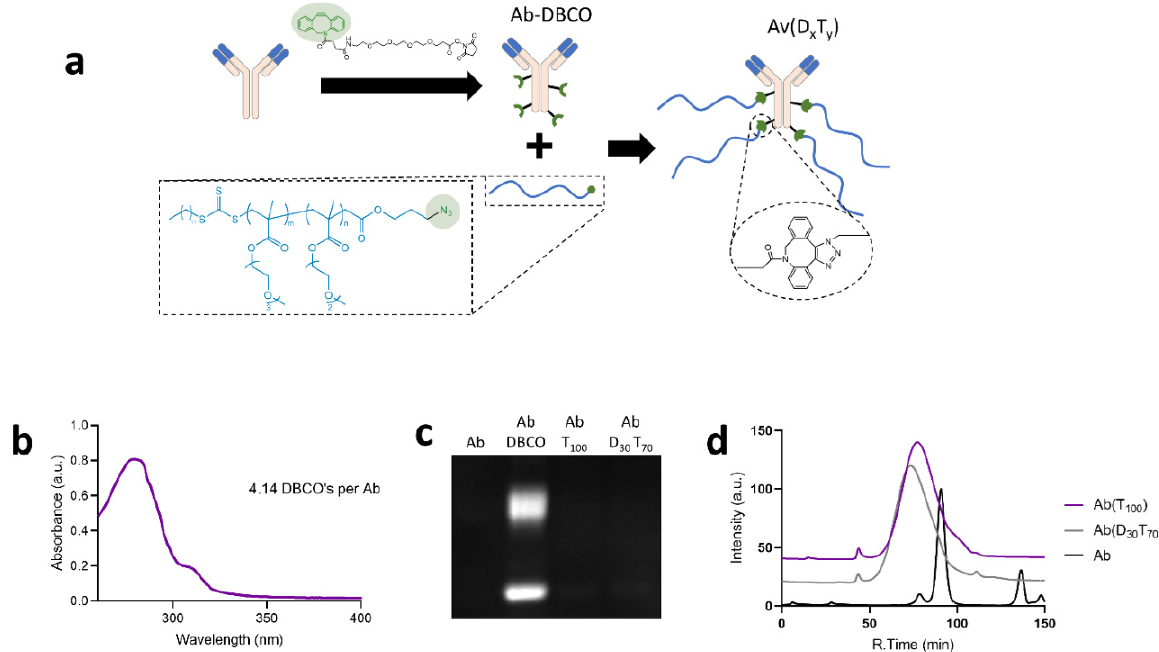
Figure 3. Synthesis and characterization of the Ab(D x T y ) conjugates. ( a ) Illustration of Ab(D x T y ) conjugate synthesis by grafting P(D x T y ) to Ab-DBCO. ( b ) Absorbance spectrum of Ab-DBCO for quantification of DBCO grafting degree. ( c ) Fluorescent SDS PAGE of antibody conjugates when reacted with Cy5-azide to detect reactive DBCO groups on the antibody. Loss of fluorescence in conjugates indicates complete consumption of DBCO (Fluorescent signal indicates free DBCO reacting with Cy5-azide). ( d ) Size exclusion chromatograms of antibody-polymer conjugates.